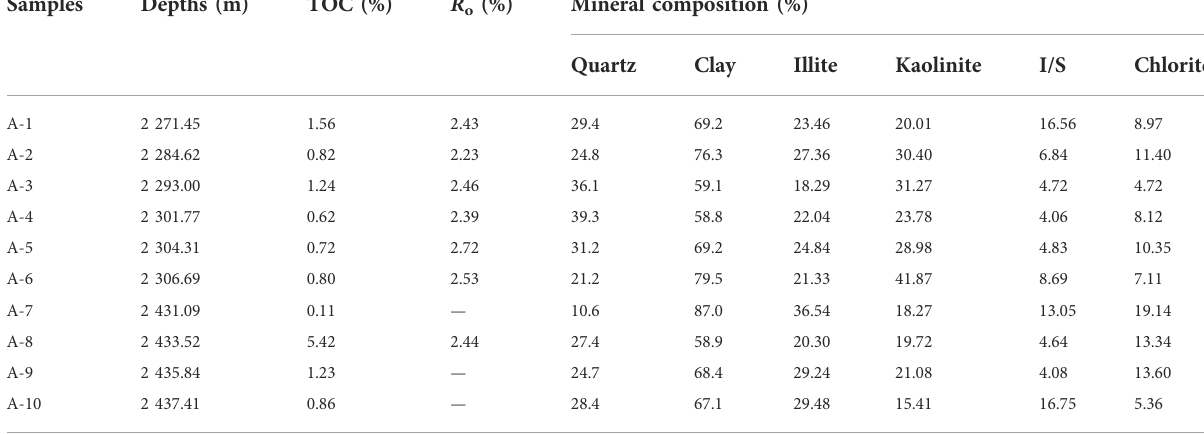
TABLE 1 The mineral composition and geochemical parameters of transitional shale reservoirs in study area.